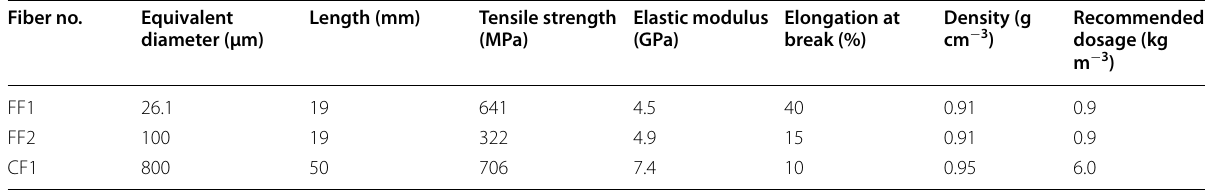
Table 1 Physical and mechanical indices of polypropylene fibers. Fiber